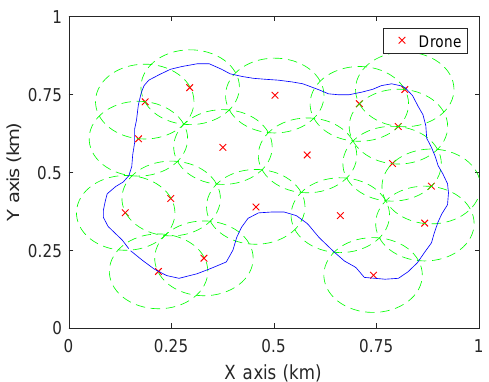
Figure 7. Deployment of 19 drones at 109 m by the proposed approach. The green dash circles are the coverage areas of drones.